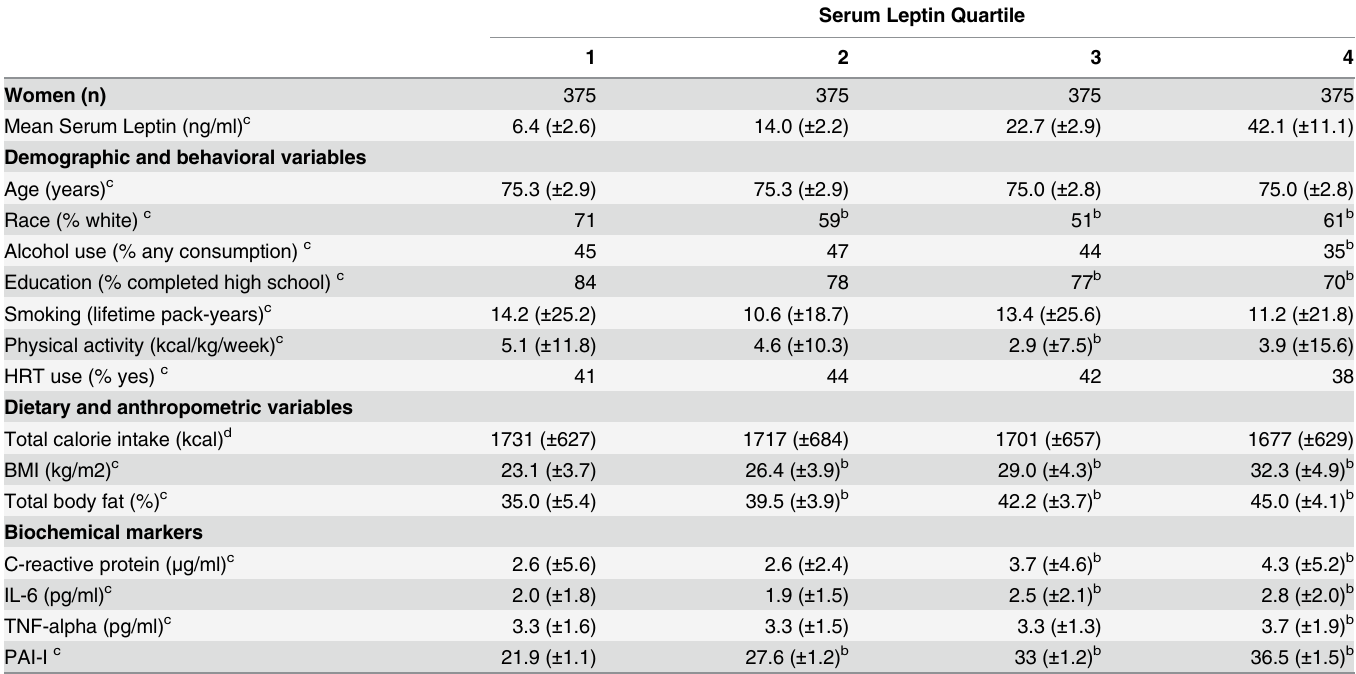
Table 2. Baseline characteristics of women by serum leptin quartile a